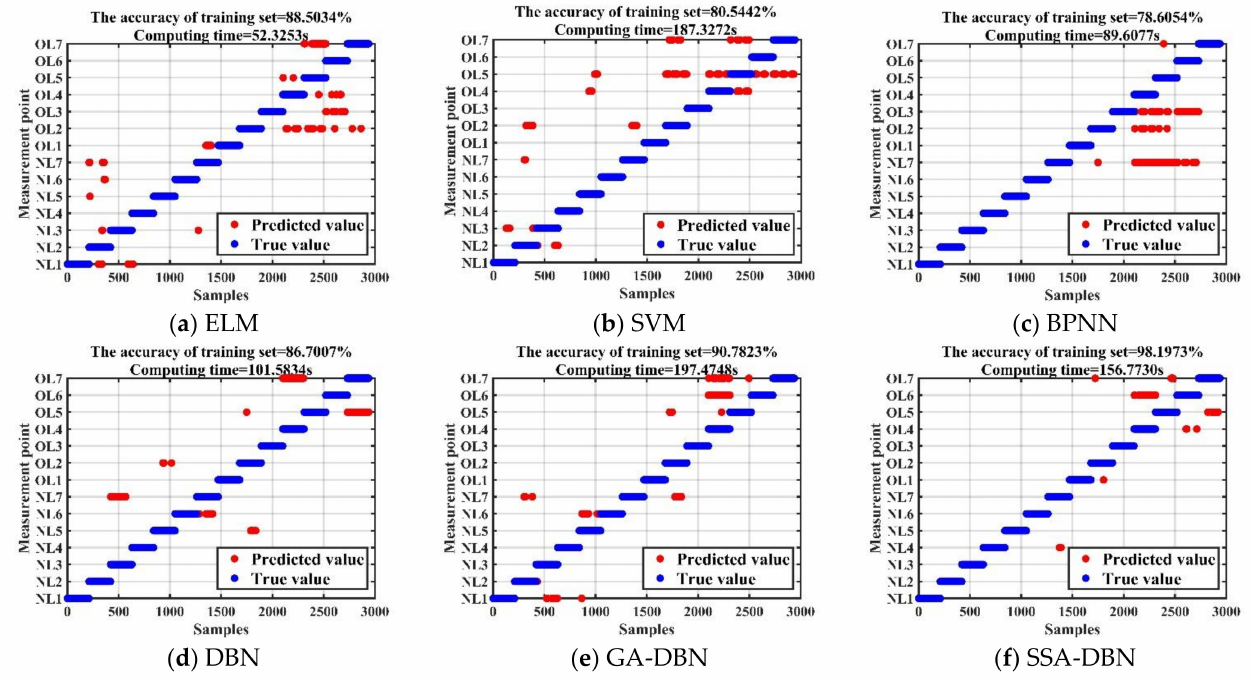
Figure 9. Experimental results of the training